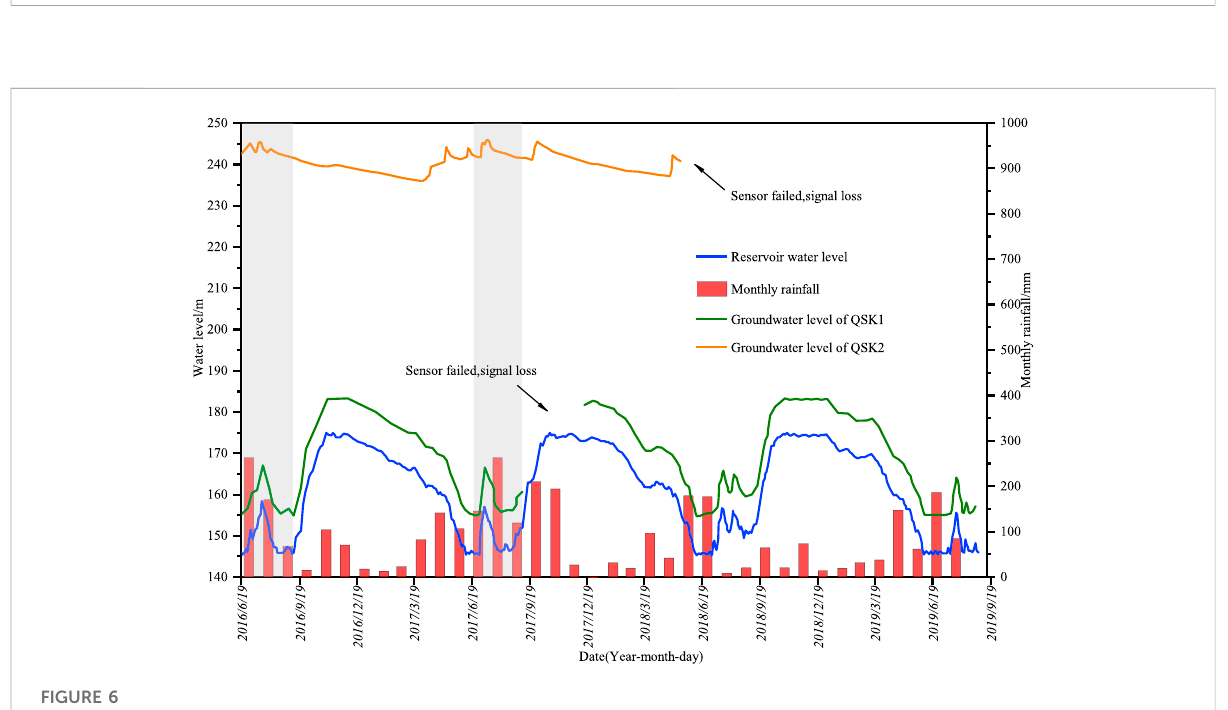
FIGURE 6 Relationship between groundwater level, rainfall and reservoir water